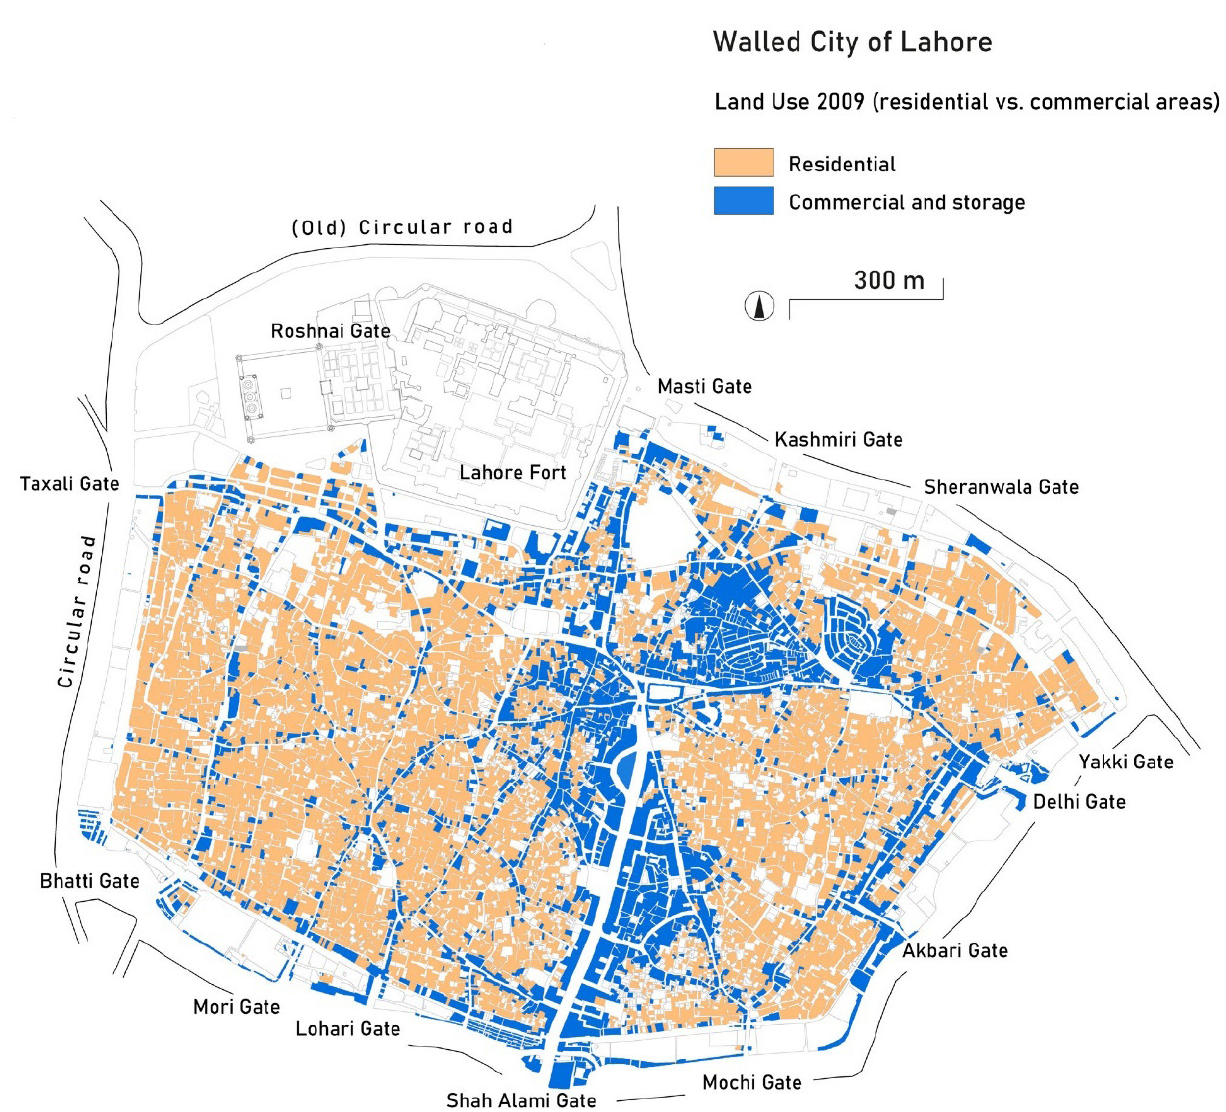
Figure 6. Walled City land use map of 2009 showing the contrast between residential and commercial/storage areas. Source: Figure by Helena Cermeño (2022) based on Jodidio